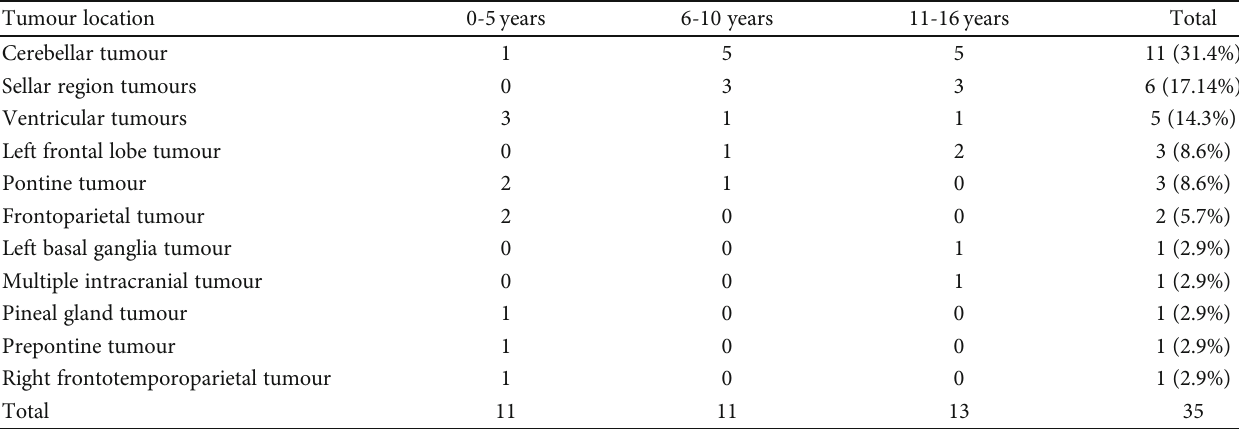
Table 3: Tumour location according to age